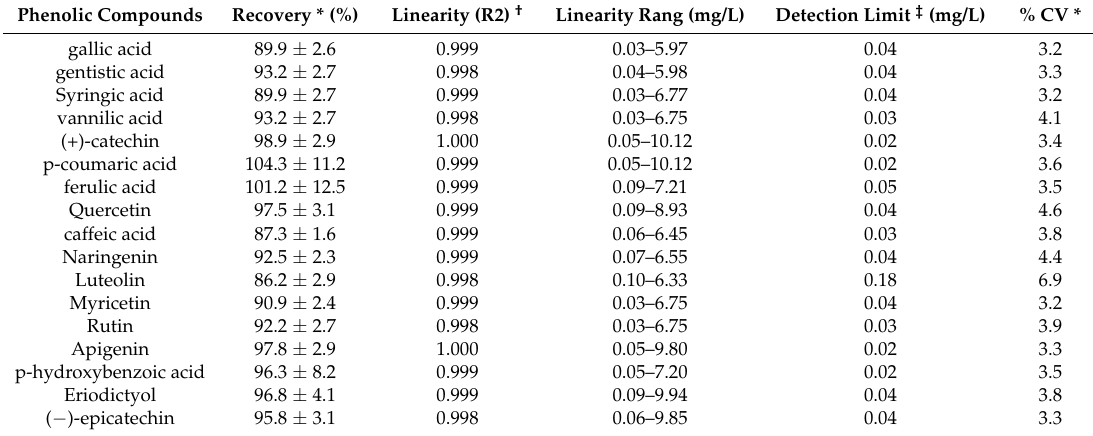
Table 2. Analytical characteristics of method for the high performance liquid chromatography (HPLC)